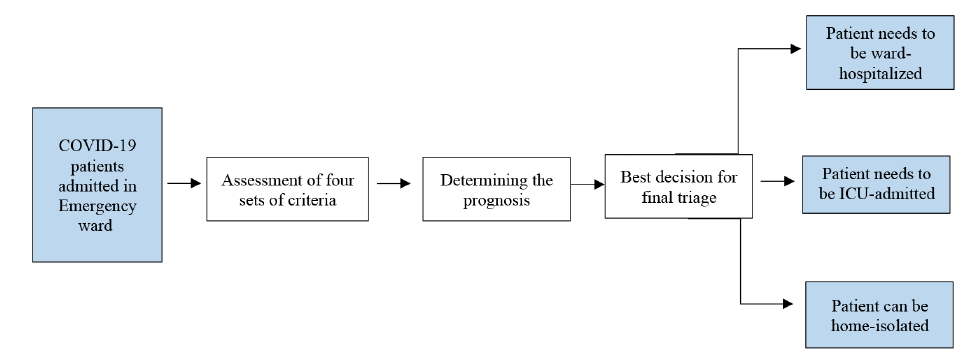
Figure 1. Chart of Triage process in COVID-19